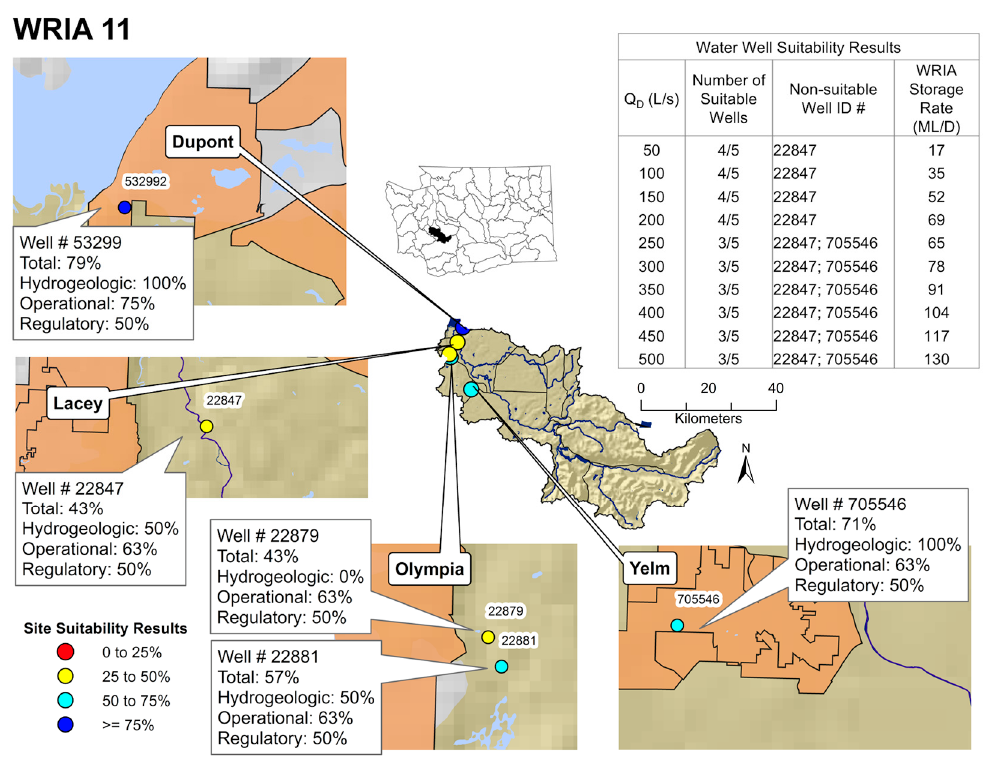
Figure 11. Results for WRIA 11.